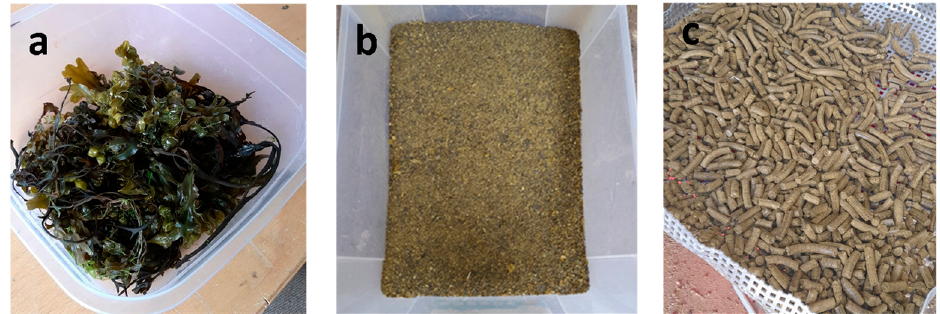
Figure A1. ( a ) Fresh seaweed; ( b ) Dried and chopped seaweed; ( c ) Seaweed pellets.